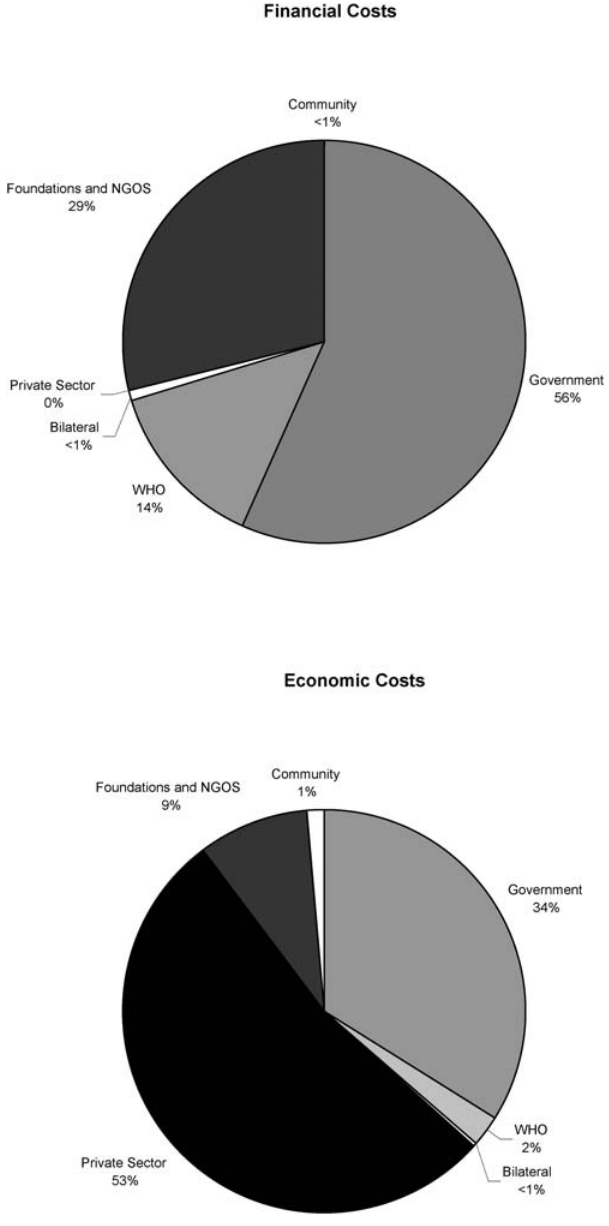
Figure 2. Sources of Funding for the MDAs Conducted by National LF Elimination Programs in Burkina Faso, Dominican Republic, Egypt, the Philippines and Tanzania (Financial Costs and Economic